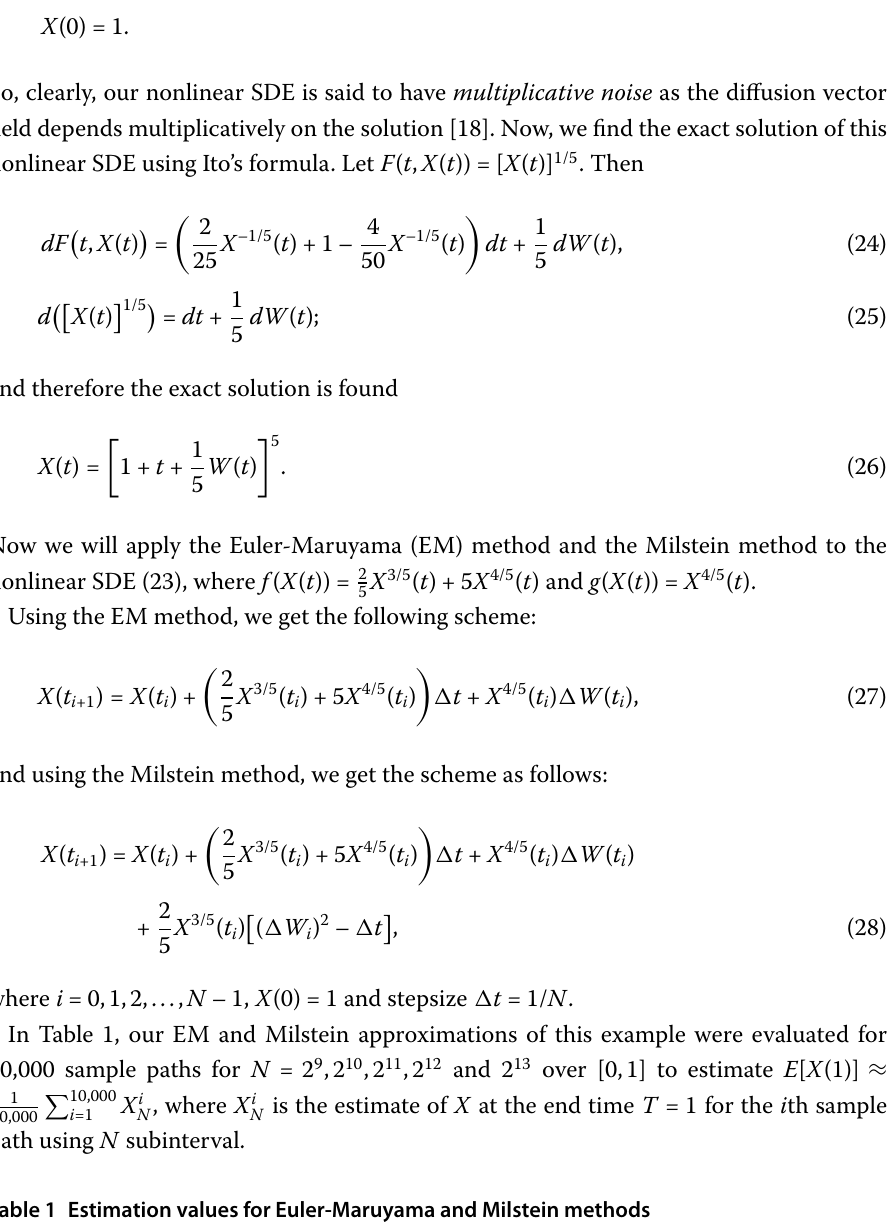
Table 1 Estimation values for Euler-Maruyama and Milstein methods